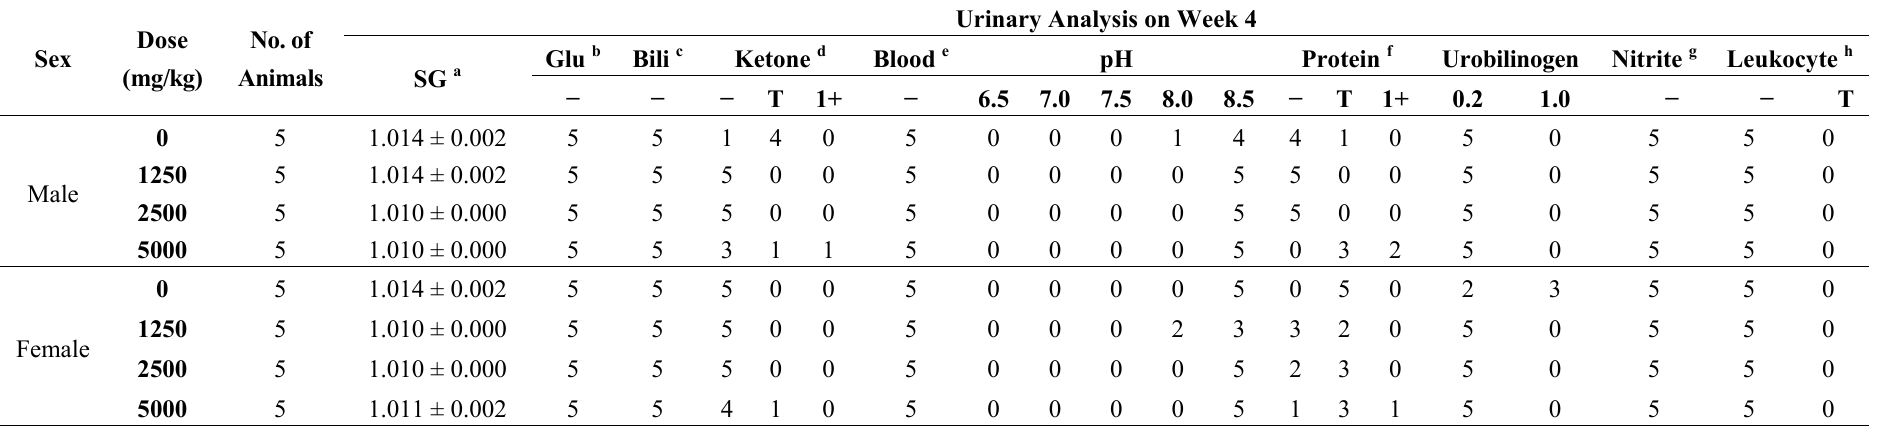
Table 4. Urinalysis findings of male and female rats treated with C. setidens for 4